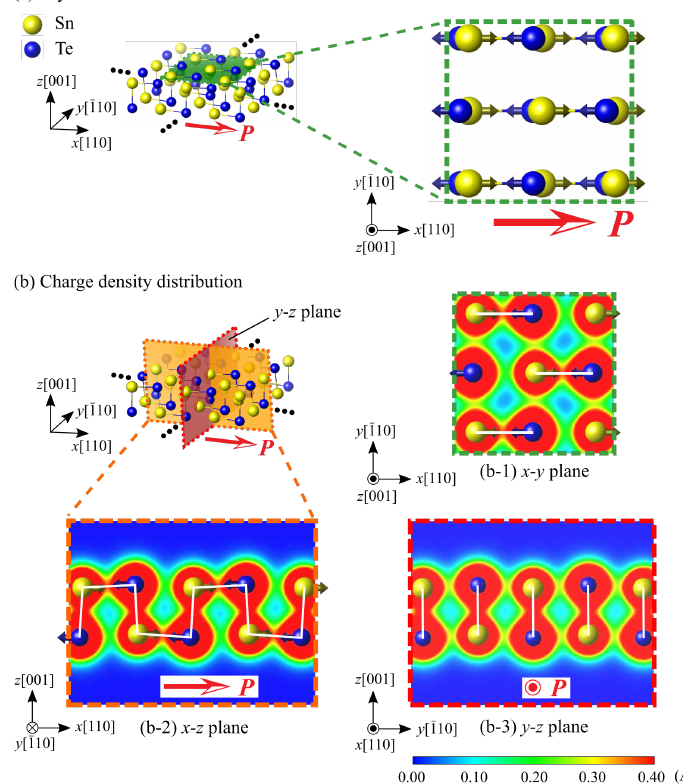
Figure 5. ( a ) Crystal structure of SnTe monolayer and ( b ) charge density distributions in SnTe monolayer. The covalent Sn-Te bonds are shown by white lines. Red arrows P indicate the direction of spontaneous polarization in the SnTe monolayer. Yellow and blue arrows indicate the displacement of Sn and Te atoms, respectively.